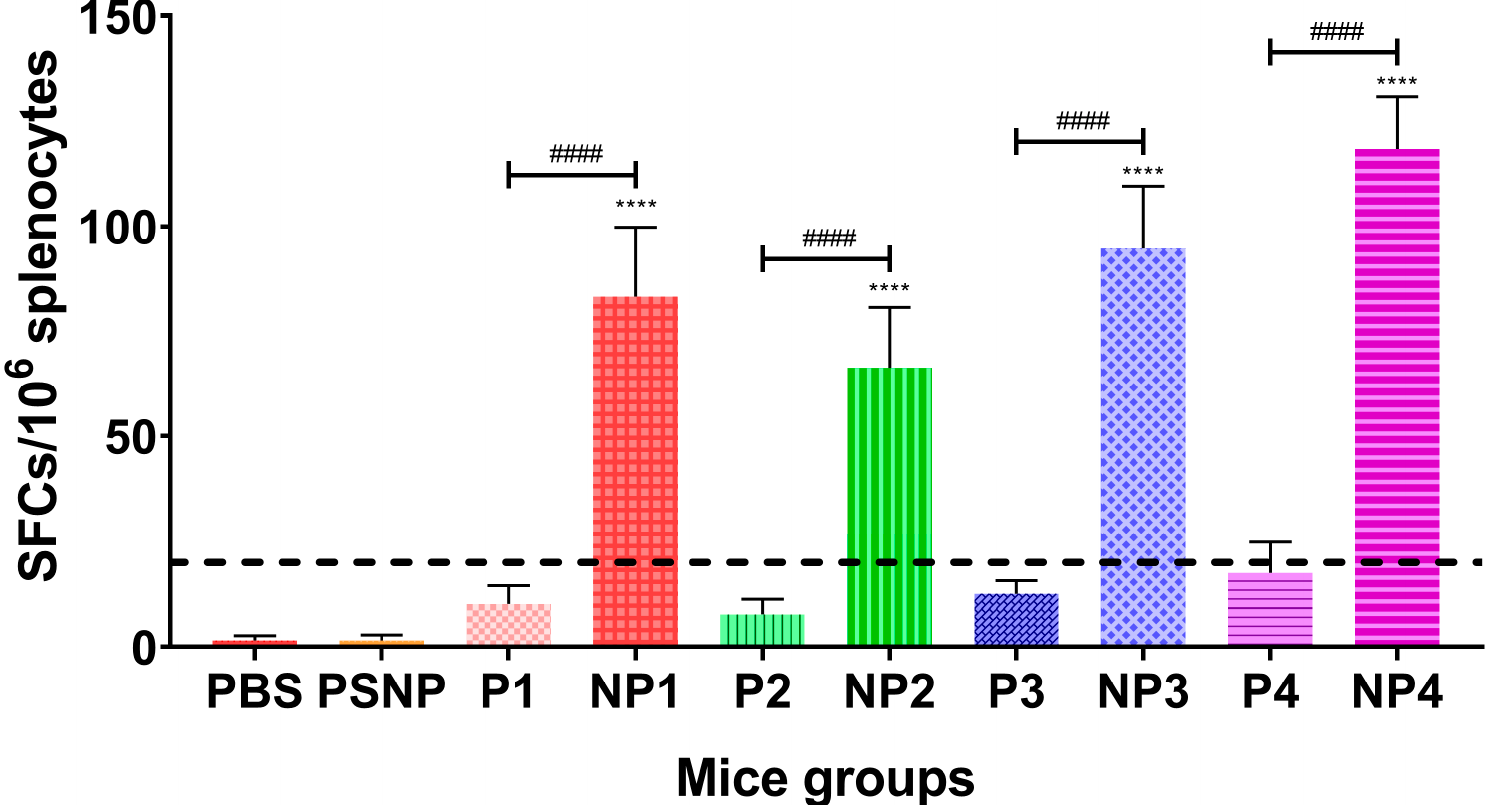
Figure 3. IFN- γ responses induced by multi-epitope peptide vaccines and nanovaccines. Data from triplicate assays were plotted using Graph Pad Prism Version 8.02 (Graph Pad Software Inc., San Diego, CA, USA) and expressed as the mean number of net spot forming cells (SFC) per 10 6 splenocytes and SDs. Semi-dotted line indicates the minimal level of a positive response (net SFC per 10 6 cells of ≥ 20). One-way ANOVA analysis with Tukey’s multiple comparison test: **** p < 0.0001 vs. PBS and #### p < 0.0001 vs. respective peptide.